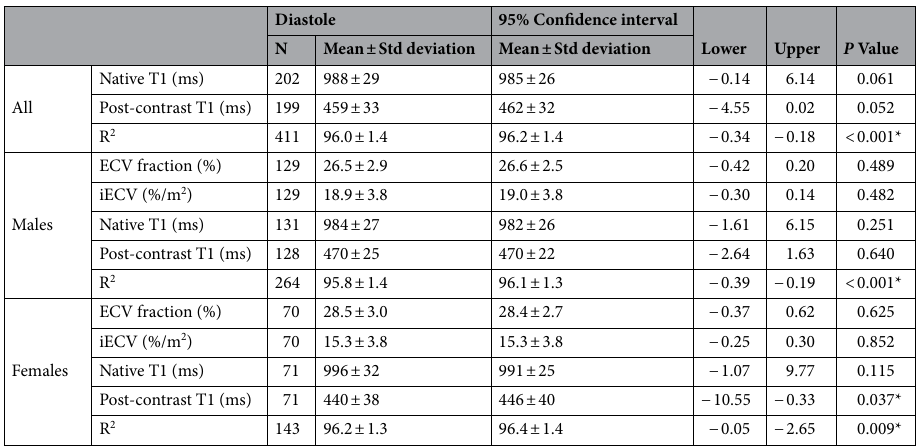
Table 2. T1 mapping—differences between diastole and systole. A comparison of mean T1 times and R 2 values in systole and diastole of all patients and of males and females to examine difference in sexes. P values with a * denotes statistical significance.